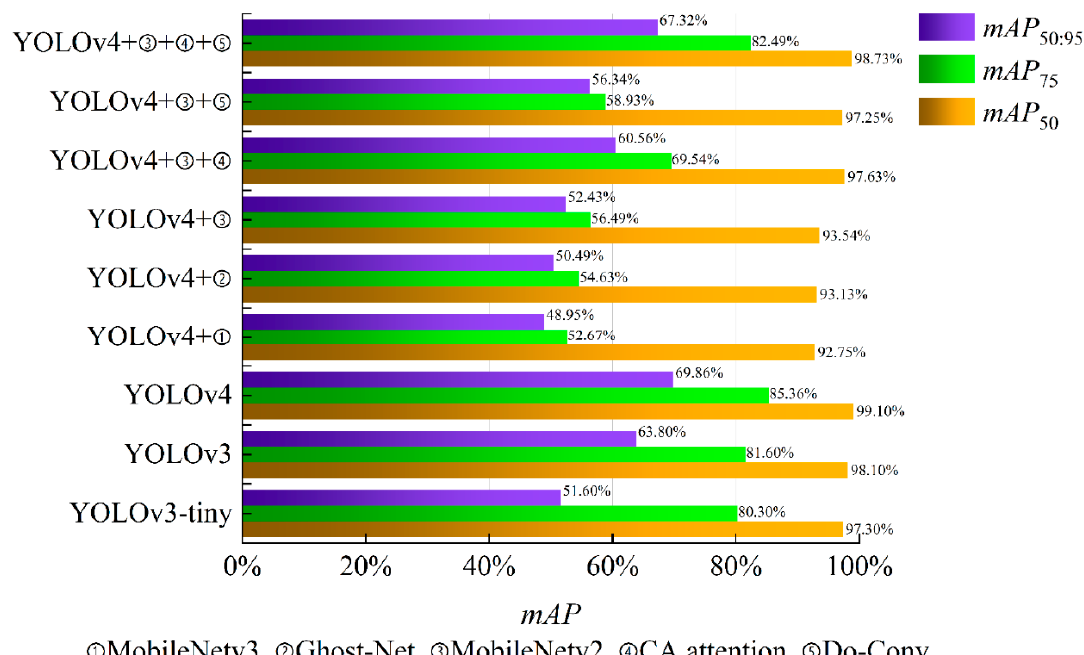
Figure 13. Contrast graph of the various improved algorithms.